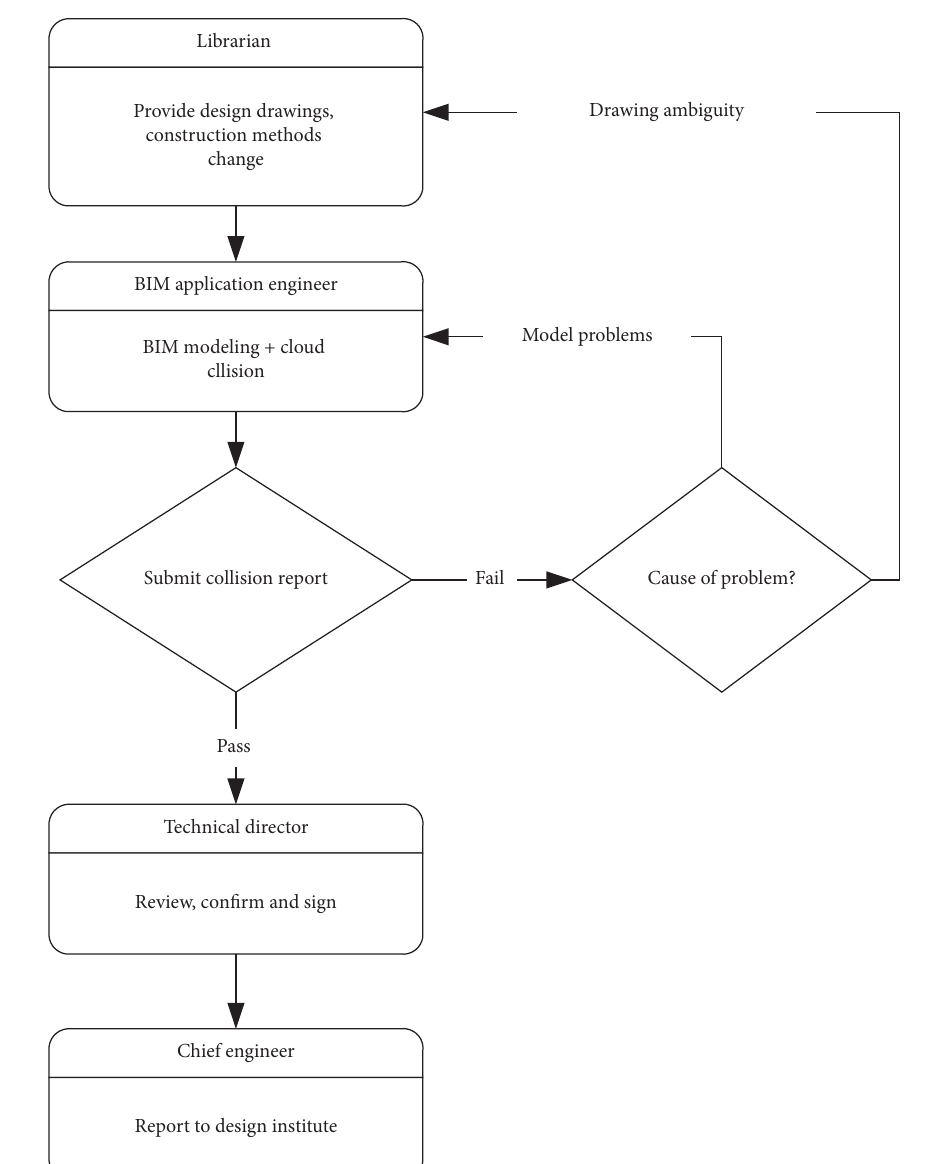
Figure 12: The application procedure of 3D